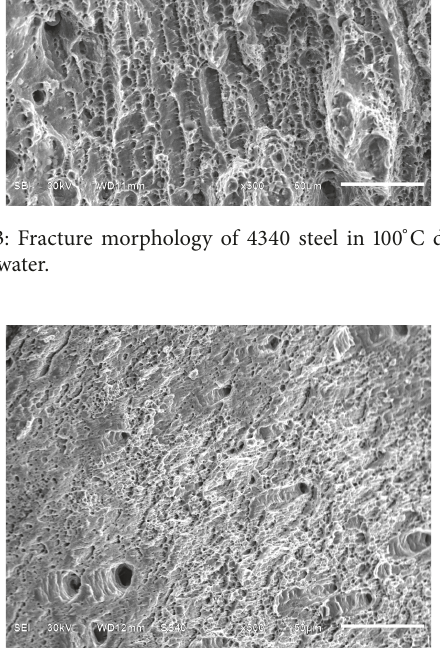
Figure 4: Fracture morphology of 4340 steel in 100 ∘ C deoxygenated 0.1mol/L chloride aqueous